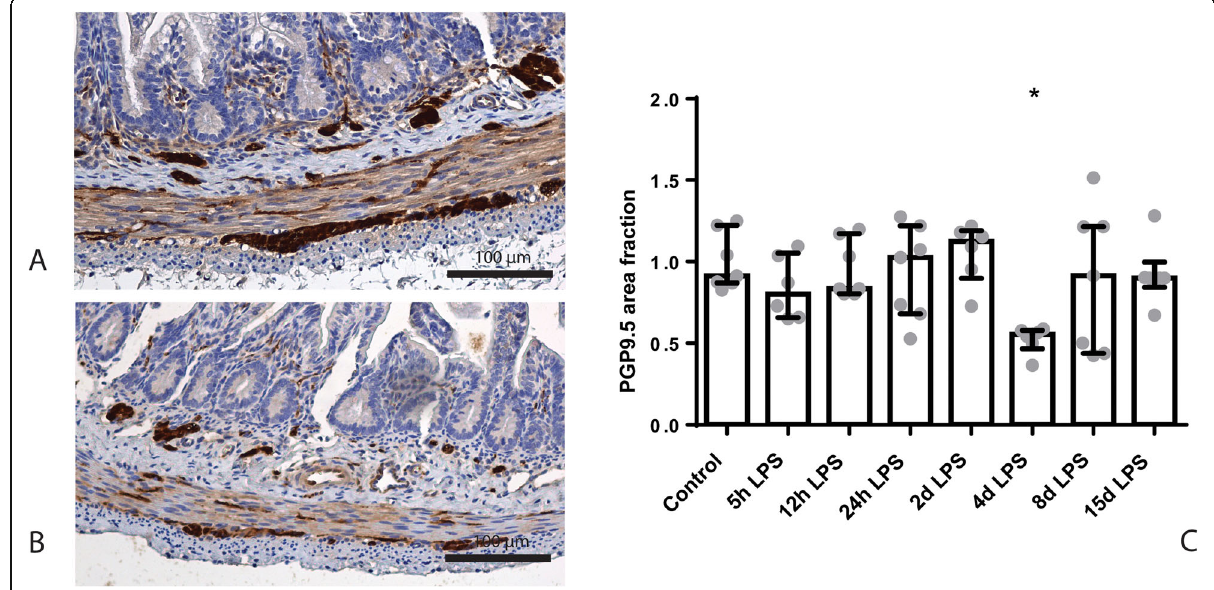
Fig. 4 Representative images of PGP9.5 immunoreactivity in the submucosal and myenteric plexus of the control ( a ) and 4 days IA LPS group ( b ). Area fraction of PGP9.5 in the myenteric plexus ( c ) as fold increase over the control value. c PGP9.5-positive surface area was decreased in animals exposed to 4 days of IA LPS. * p < 0.05 compared to